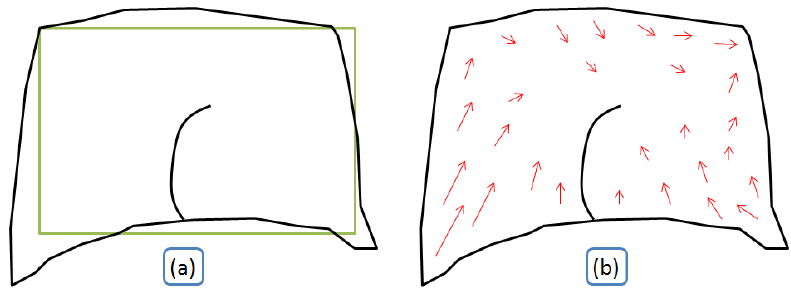
Figure 2. The principles of rubber sheeting conflation ( a ) the black geometries match with the green ones ( b ) a vector field is computed to make the black features fit into green feature’s